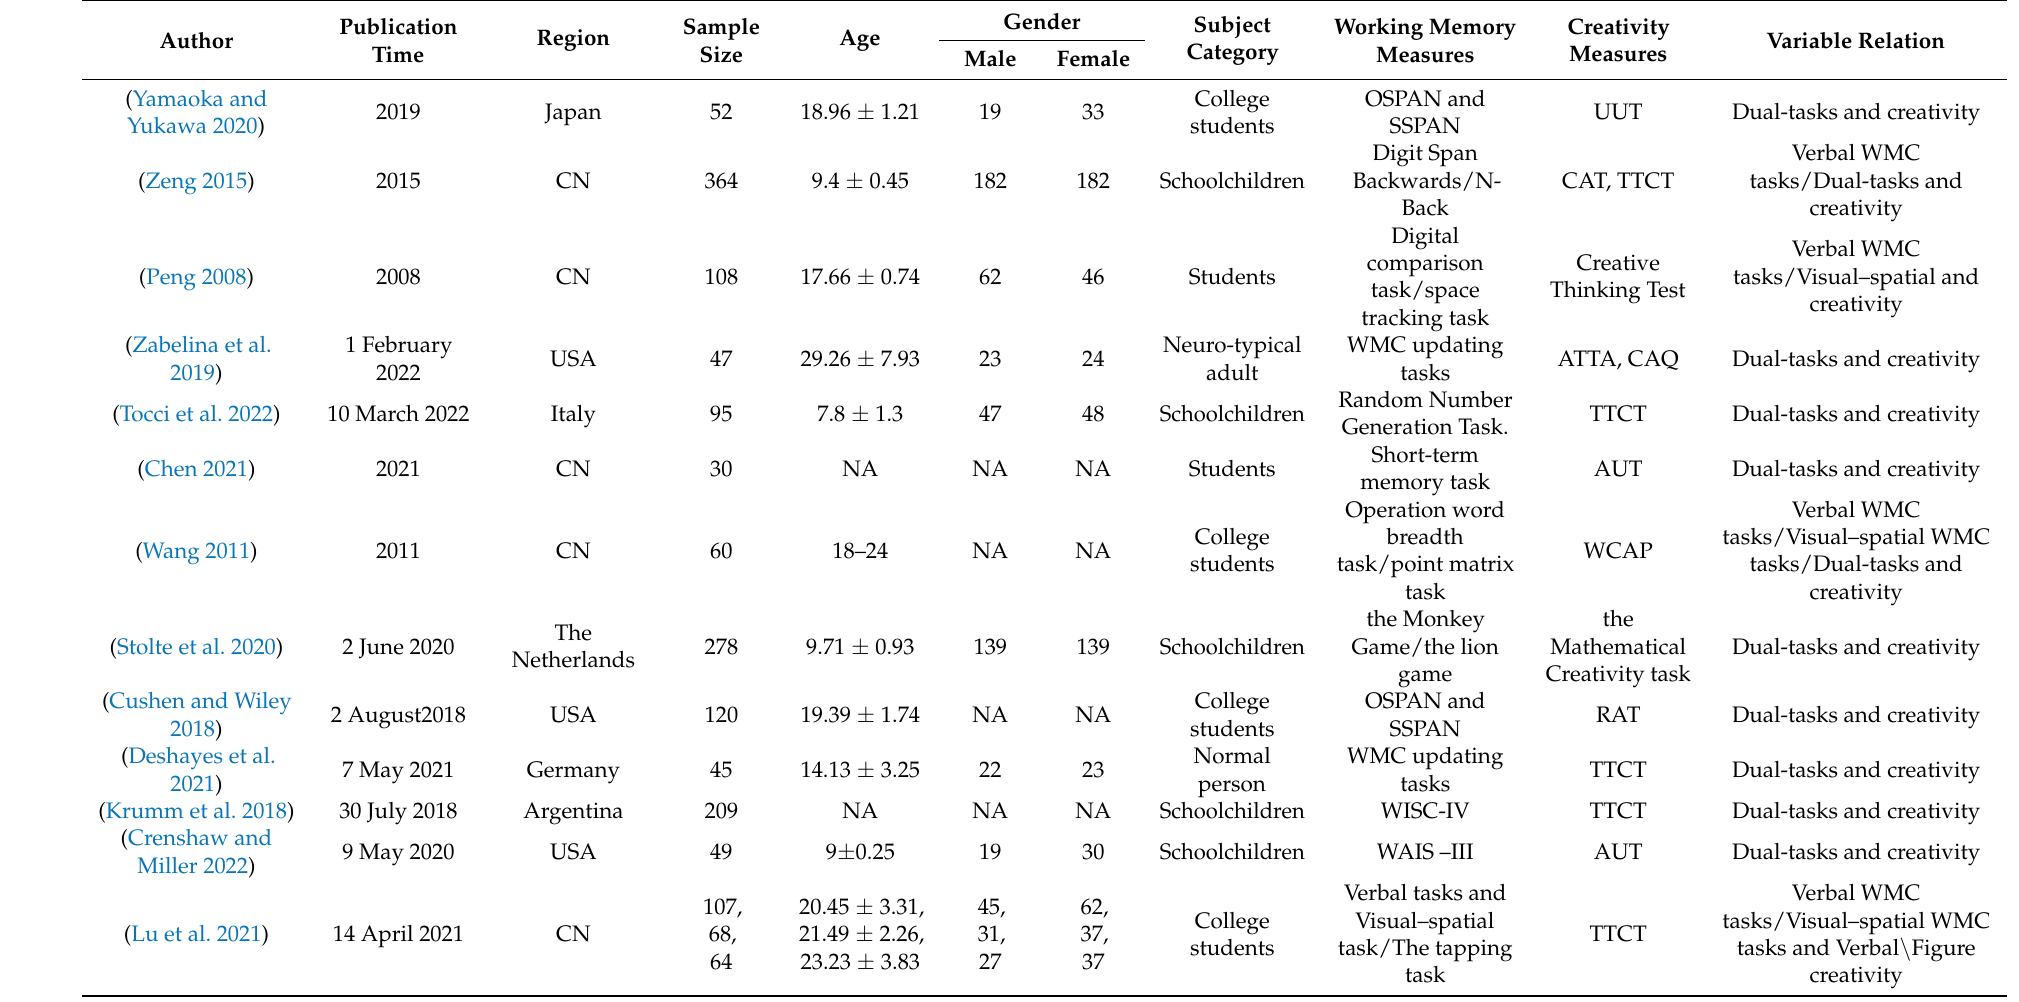
Table 1. Summary of characteristics of included studies. N.A. = not